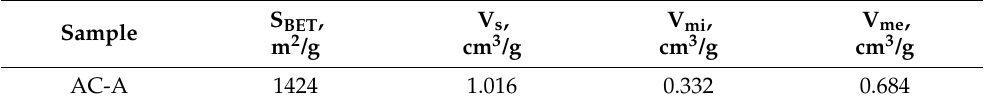
Table 1. Structural parameters and specific surface area of the AC-A enterosorbent.